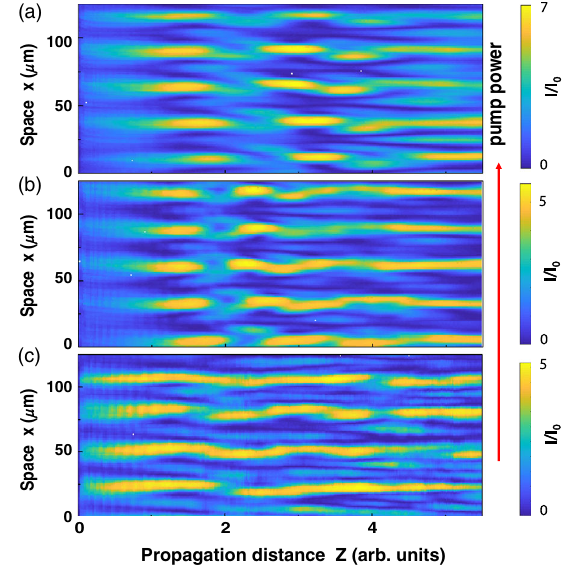
FIG. 5. From the integrable to the nonintegrable regime. We show the nonlinear evolution detected for k ¼ 0 . 021 μ m − 1 and A ¼ 0 . 5 by varying the external pump power: (a) P ¼ 6 mW, (b) P ¼ 2 mW, and (c) P ¼ 0 . 5 mW. The recurrent behavior in panel (a) is superseded by the appearance of spatial solitons (c) as the dynamics is far from integrability (highly saturated